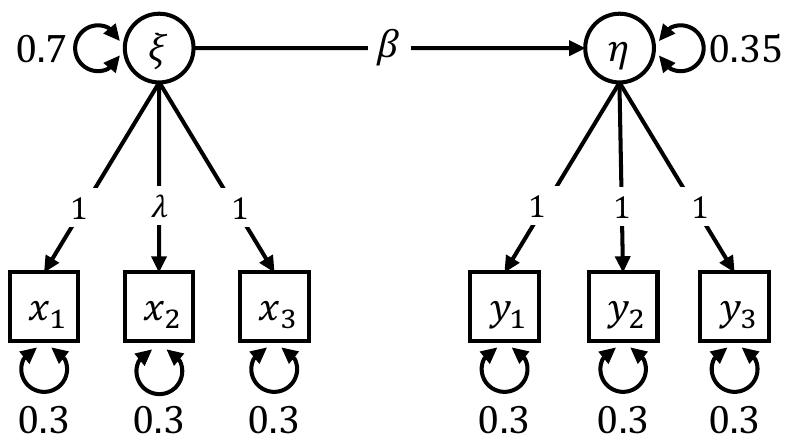
Figure 7. Path diagram of the simulation model. The factor loading λ varied between two groups in Simulation III and the regression parameter β differed across individuals in Simulation